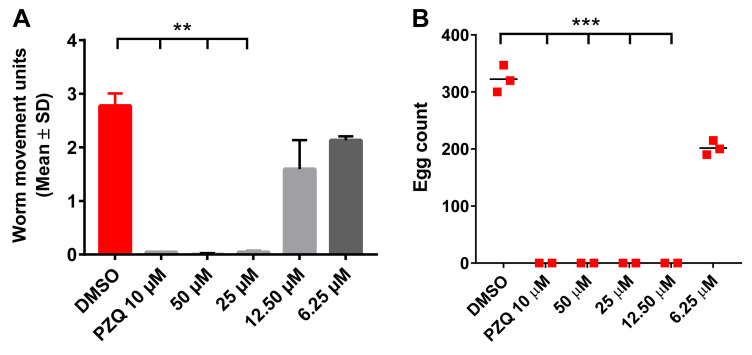
The most potent anti-schistosomula compound (7) affects adult worm motility and egg production.A dose response titration (50 - 6.25 µM) of compound 7 was performed to assess its potency on
S. mansoni adult worms (three worm pairs/well for each condition).
Panel A - Schistosome motility was quantified using WormassayGP2 at 72 h.
Panel B - Eggs were collected and enumerated by brightfield microscopy at 72 h. Each titration was performed in three independent screens. A Kruskal-Wallis ANOVA followed by Dunn’s multiple comparisons test was performed to compare each population mean to DMSO mean value. ** and *** represent
p < 0.0055 and
p < 0.0003, respectively.